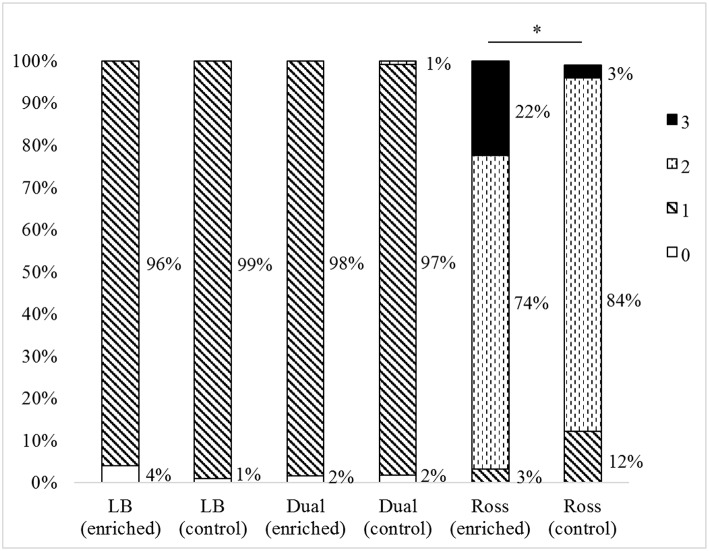
Chest cleanliness scores (percentage of animals assessed for each score) of the three strains (LB, Dual, Ross) for the two treatments (enriched and control pens). Significant differences between treatments within strains are marked by an asterisk, P < 0.05.